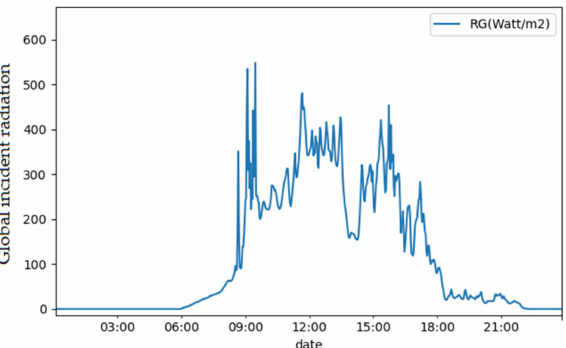
Figure A4. Global incident radiation (w/m 2 ) of 14 June 2018 measured at a time step of 2